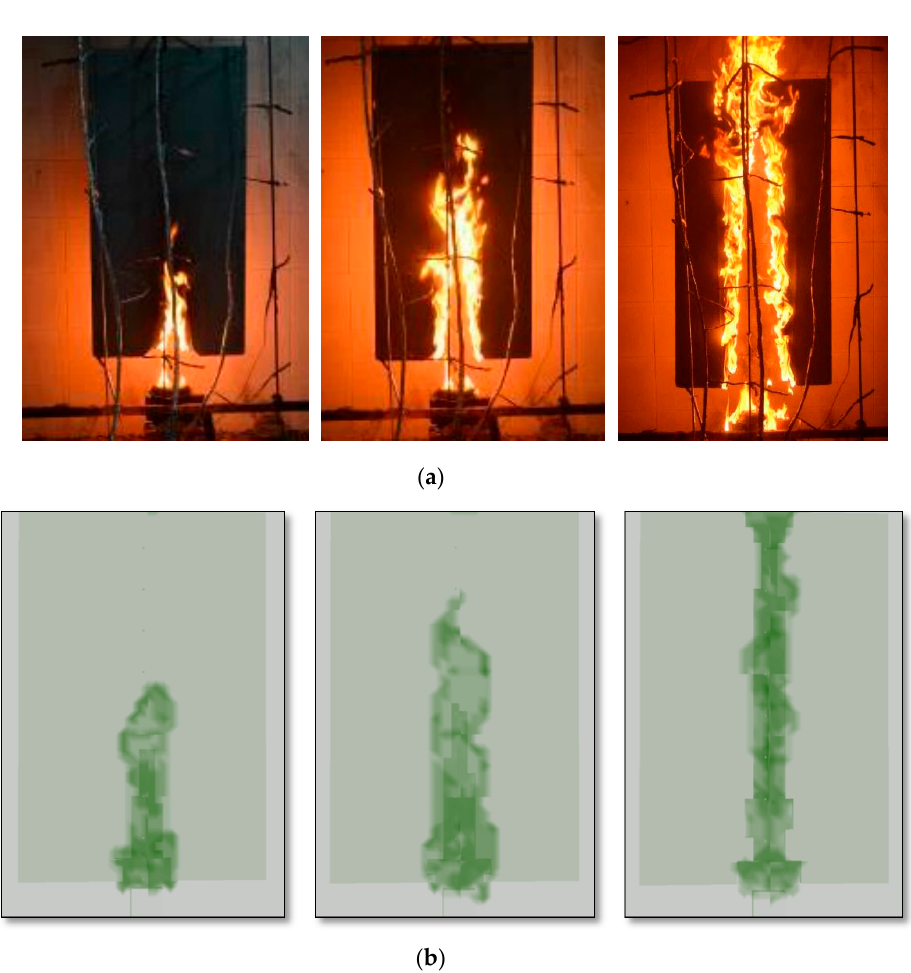
Figure 6. ( a ) Upward flame in experiment; ( b ) Upward flame ( > 200 kW/m 3 ) in FDS simulation.